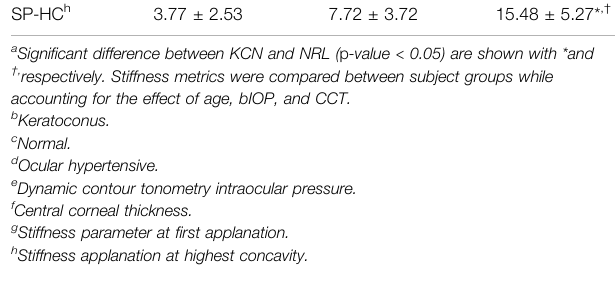
a Signi fi cant difference between KCN and NRL ( p -value < 0.05) are shown with *and † , respectively. Stiffness metrics were compared between subject groups while accounting for the effect of age, bIOP, and CCT. b